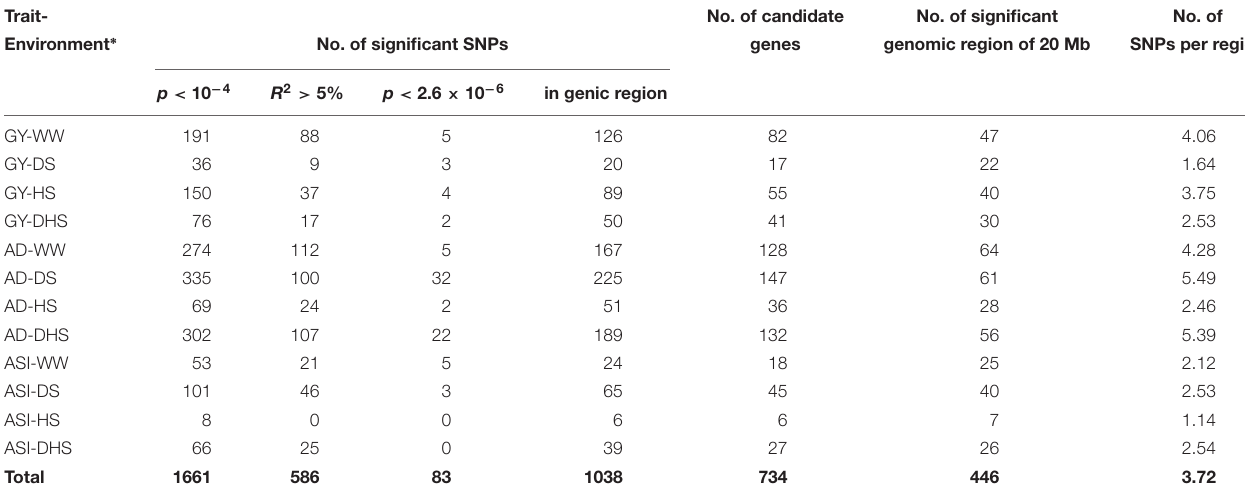
TABLE 1 | The genome-wide association mapping results of the 12 trait-environment combinations in the DTMA panel using 381,165 filtered SNPs.